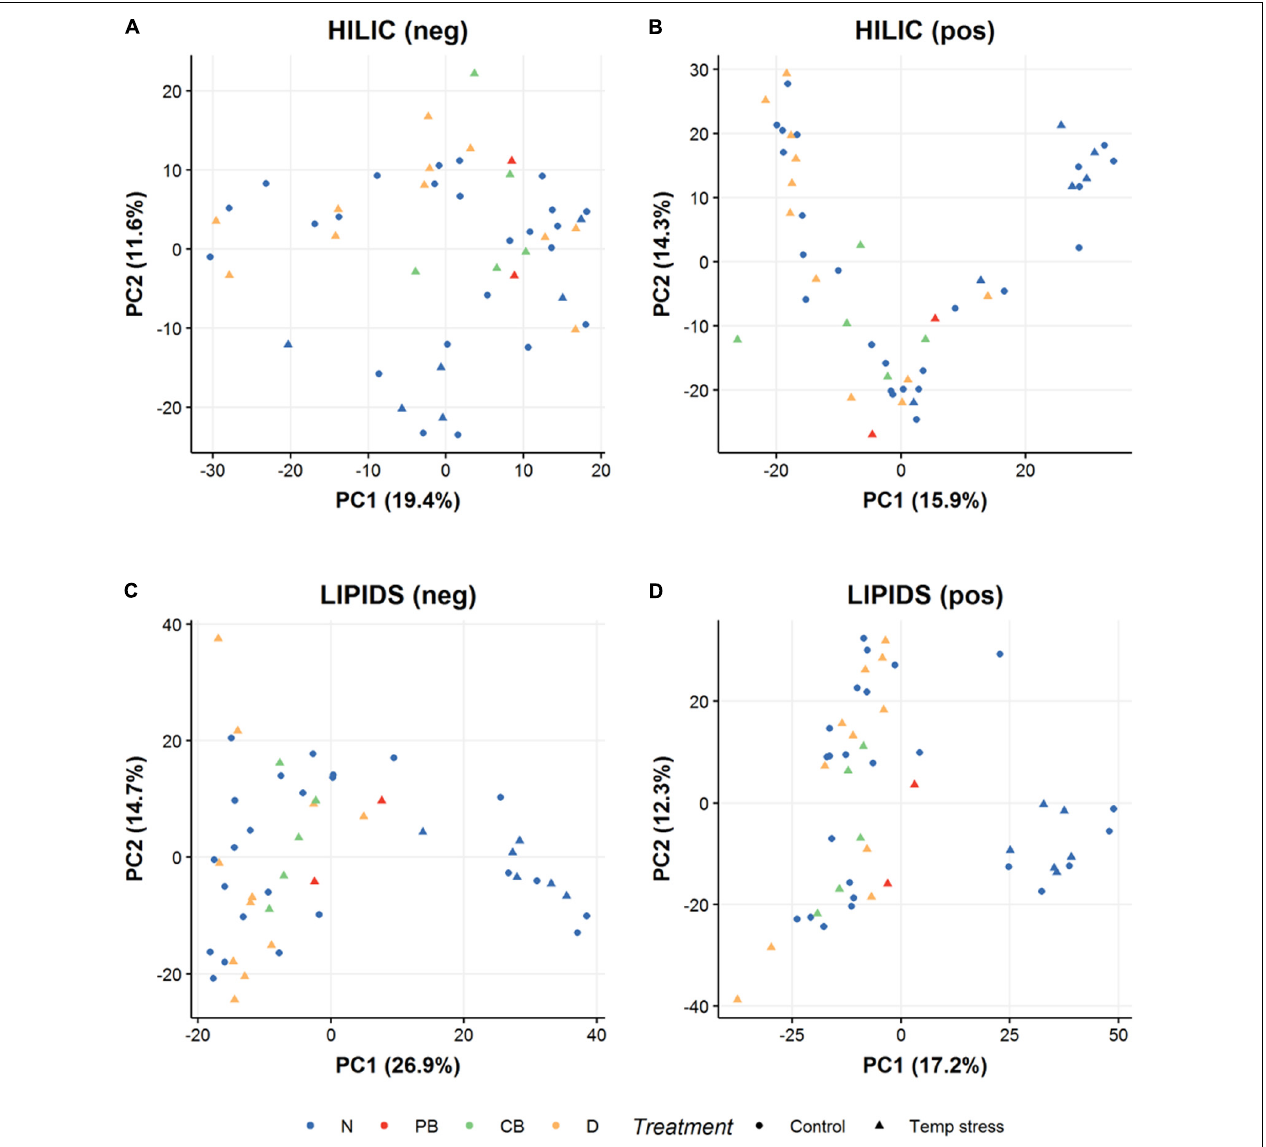
FIGURE 3 | PCA scores representation of metabolomic profiles of A. hyacinthus and A. millepora exposed to acute temperature stress (28 days at 30.75 ◦ C). Results from polar HILIC coral extracts in (A) negative mode and (B) positive mode LC-MS, and from non-polar LIPID coral extracts in (C) negative mode and (D) positive mode LC-MS. Circles represent control samples and triangles represent those exposed to an acute temperature stress. Colors refer to the fate or health state of the corals after the prolonged temperature stress period which ran after the sampling for the metabolomic analysis; blue = not bleached, red = partially bleached, green = completely bleached and orange = rapid tissue necrosis and